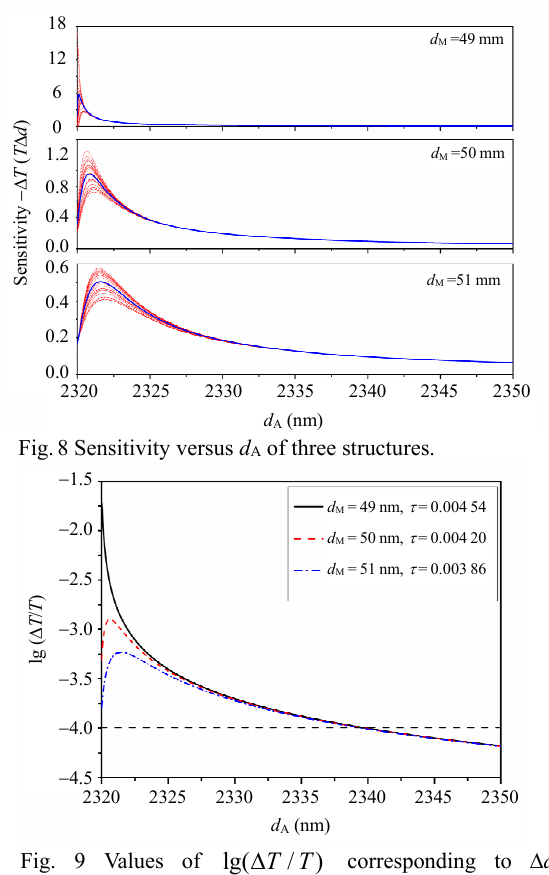
Fig. 9 Values of lg( / ) T T  corresponding to  d = 0.001 nm for three structures.